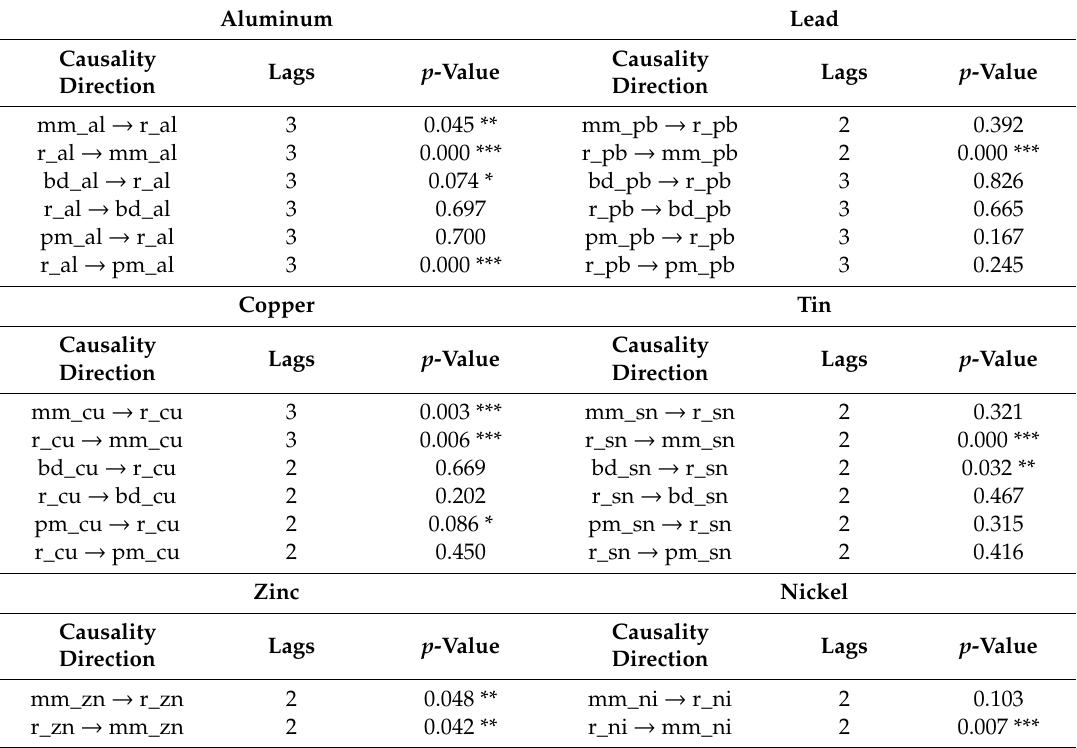
Table 2. Granger causality tests: First